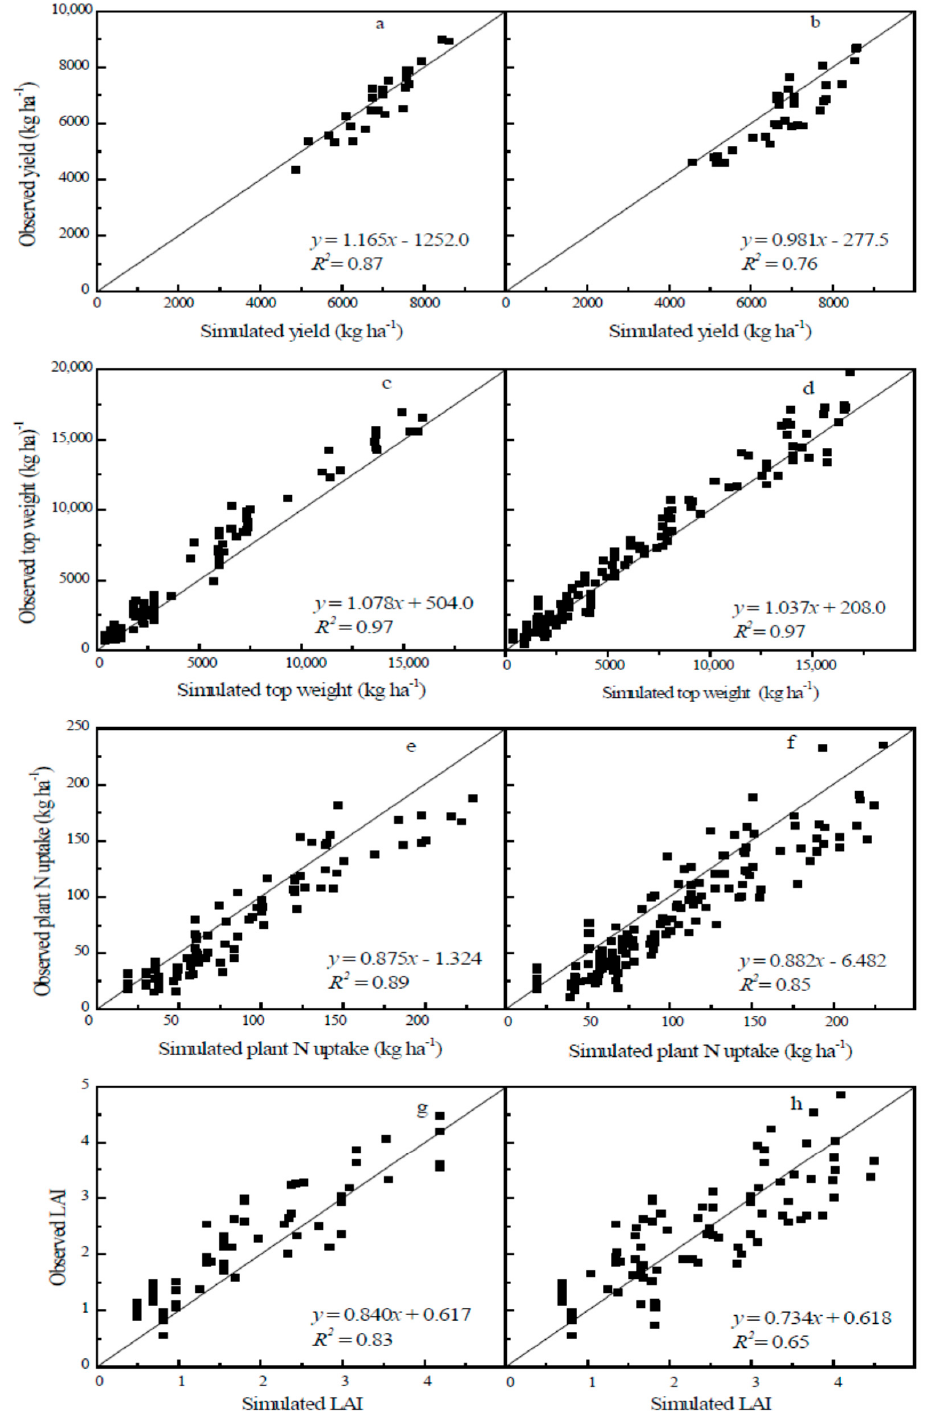
Figure 1. Calibration (left) and evaluation (right) results for simulated vs observed yield ( a and b ), top weight ( c and d ), LAI (e and f ), and N uptake ( g and h ) over five N rates, three varieties, and several seasons. Table 2. Summary of CERES-Rice calibration and evaluation of three varieties, including four variables (yield, plant N uptake, top weight, LAI) with the experimental data during 2011–2016.